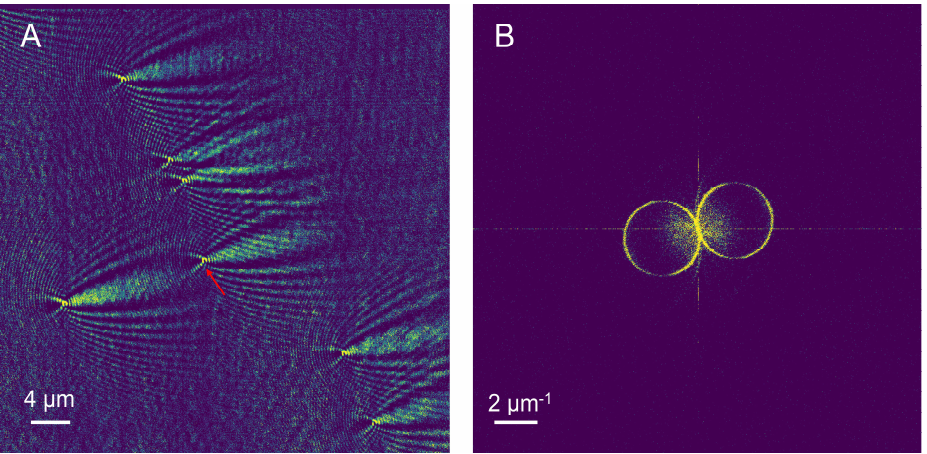
Figure 4. SPRM imaging for 200 nm polystyrene nanospheres; ( A ) and their two-dimensional Fourier transform ( B ).